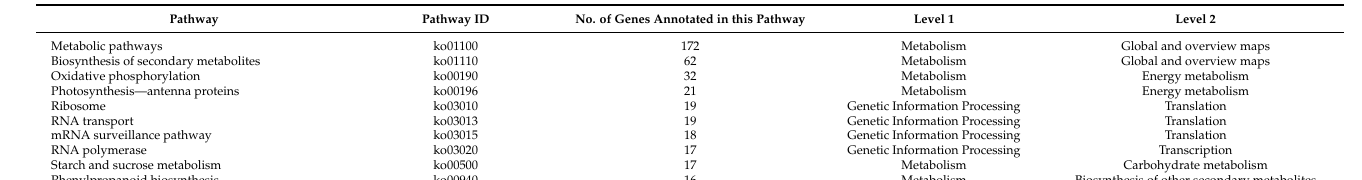
Table 4. Significant 15 KEGG pathways based on genes differentially expressed in high-B (TB 10 mM)-